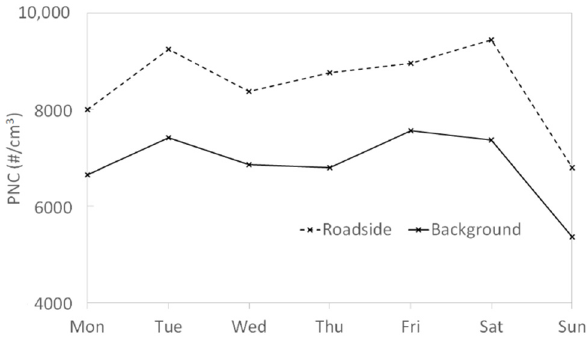
Figure 7. PNC average weekly profile at both sites over the measurement period.